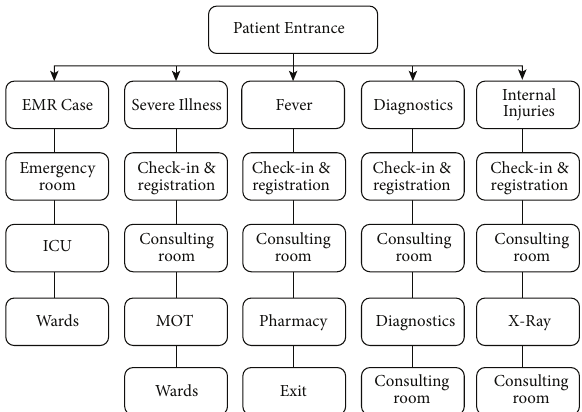
Figure 9. Types of patient flow